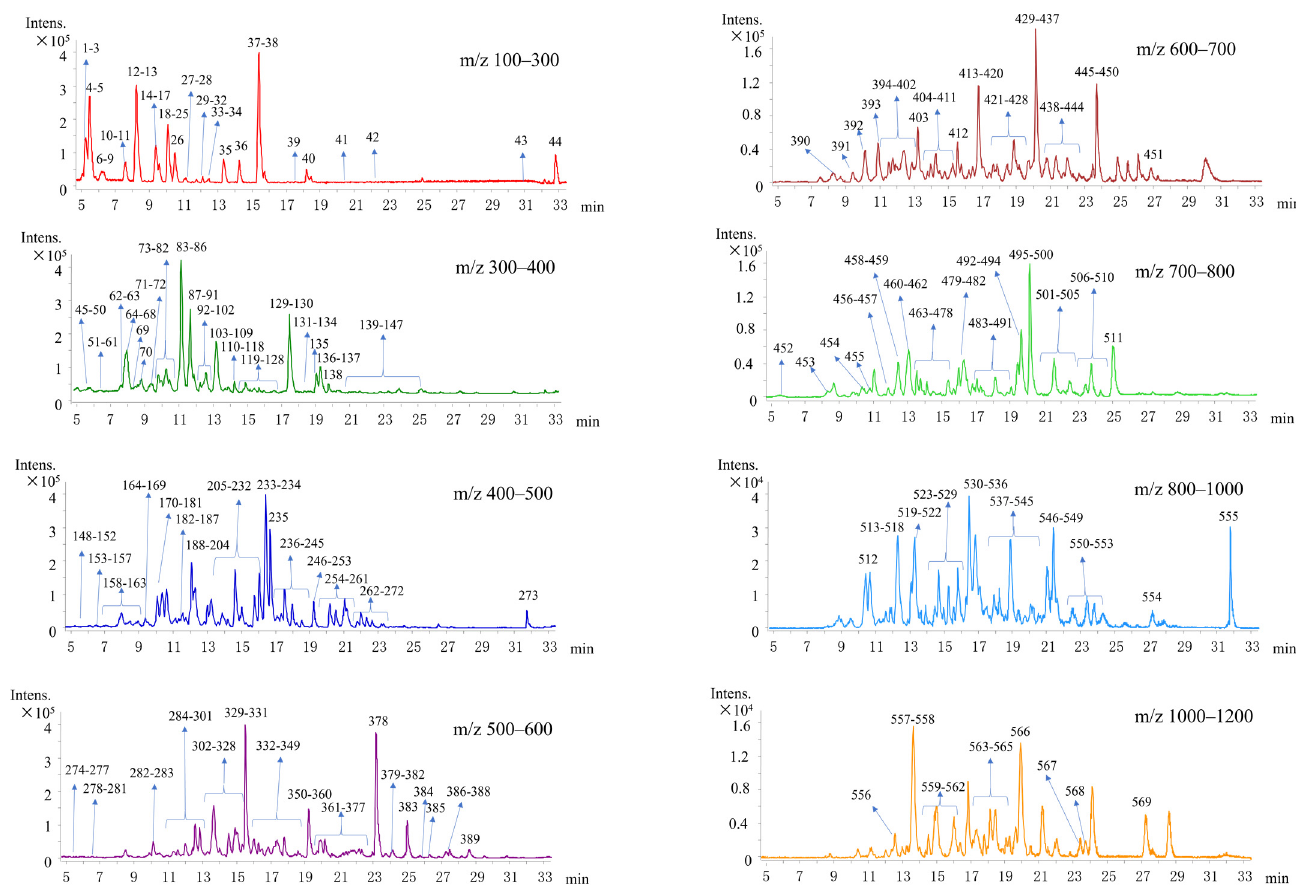
Figure 1. Strategies developed for screening specific peptides. ( A ) Proteomic strategy; ( B ) our strat- egy. Our strategy ( B ) directly finds specific peptides by comparing the peptide profiles between authentic and fake samples. In contrast, conventional proteomic strategy ( A ) finds specific peptides by searching the related protein database.